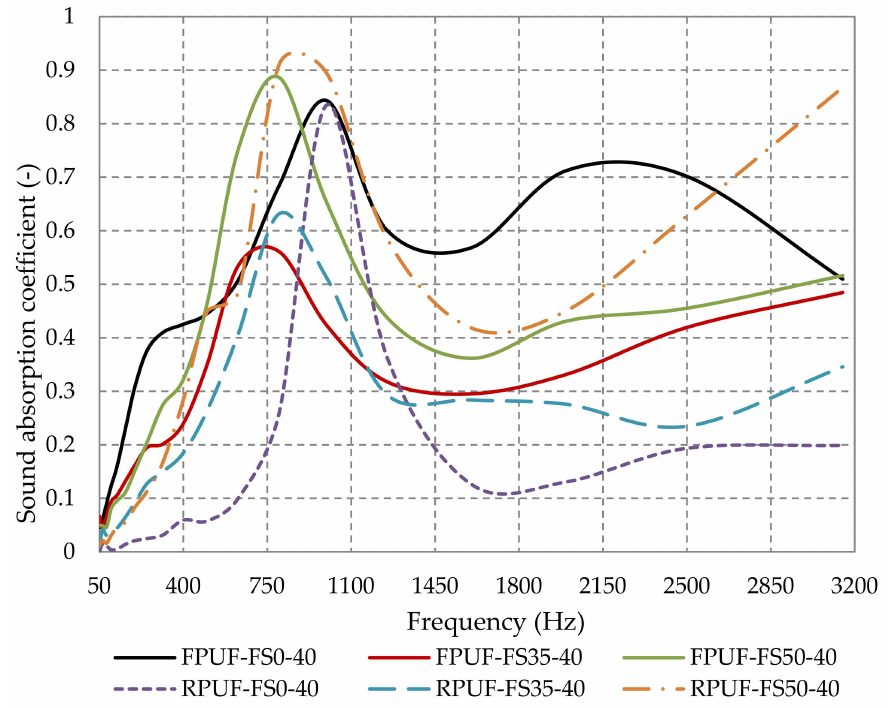
Figure 12. Sound-absorption coefficient variation with the type of polyurethane foam and the fir sawdust